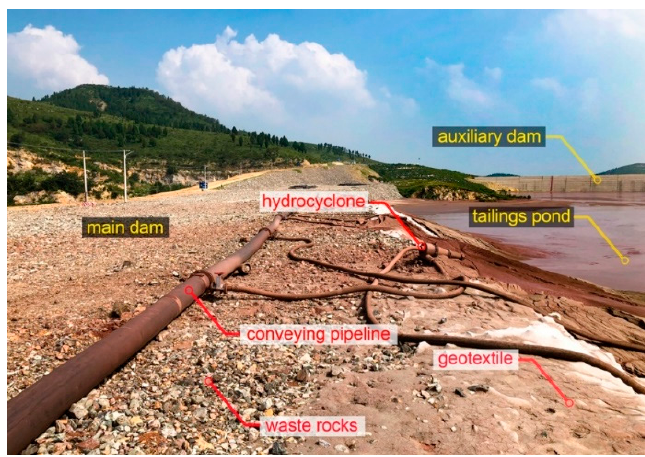
Figure 3. Upstream raising of the Yujiaquan main dam with tailings, waste rocks, geotextile, and hydro-cyclones.